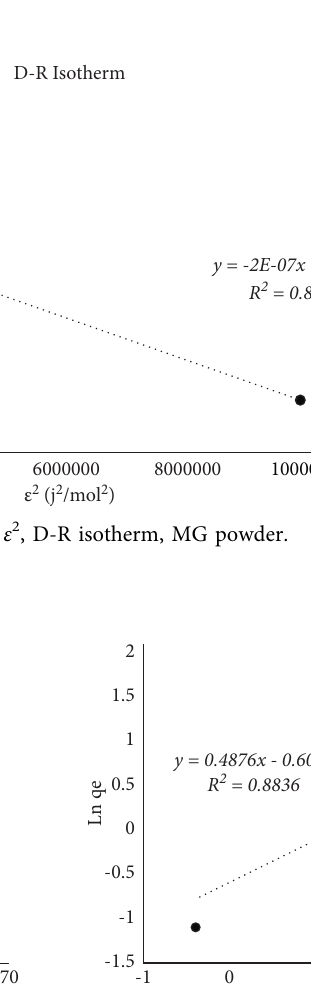
Figure 6: Ln( q e ) variations to Ln( C e ), Freundlich isotherm, MG powder.